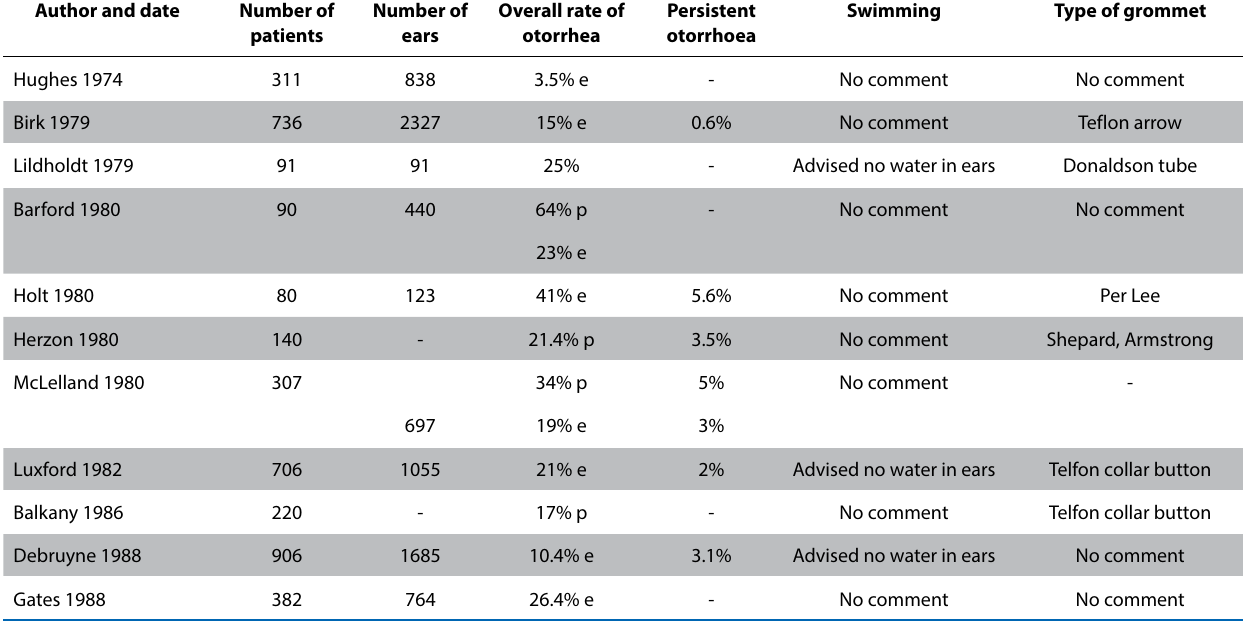
Table I: Summary of papers recording rates of otorrhoea in children with grommets